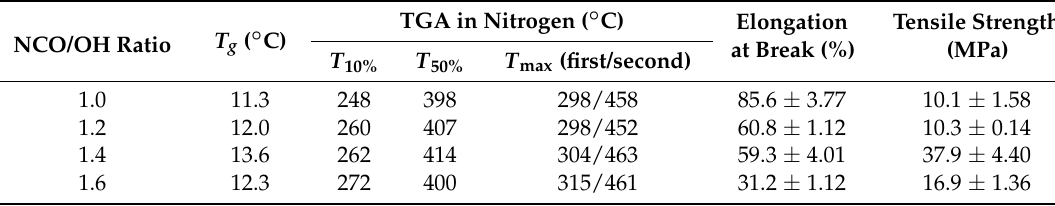
Figure 4. Differential scanning calorimetry (DSC) analysis of PU-DOD with different NCO/OH ratios. Table 1. Thermal and mechanical properties of PU-DOD.